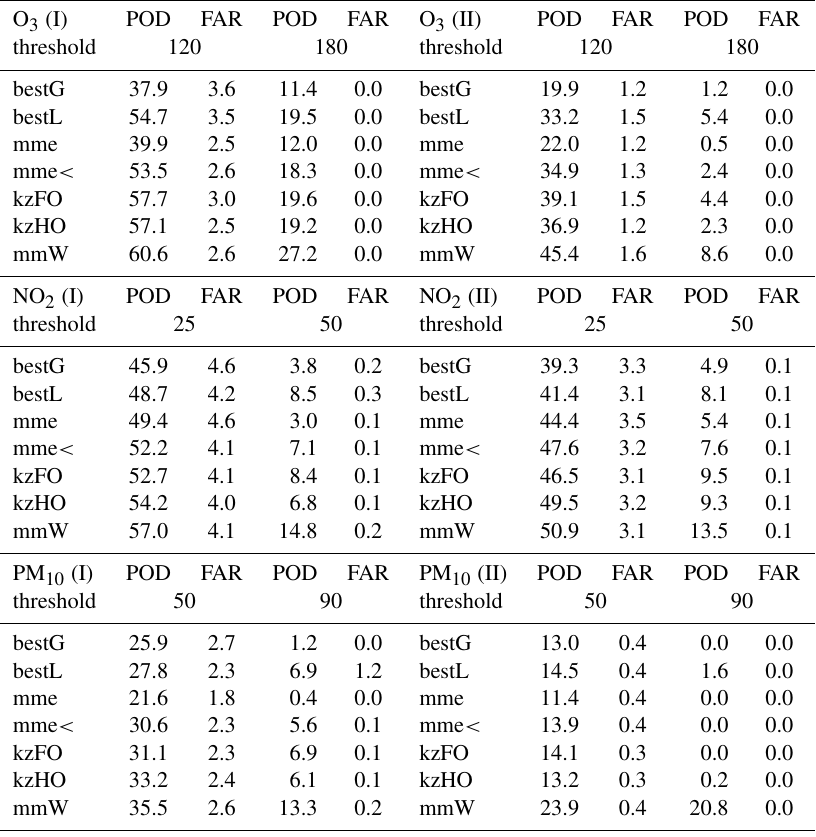
Table 4. The probability of detection (POD) and false alarm rate (FAR) from (a) the best deterministic models, globally (bestG) and lo- cally (bestL), (b) the unconditional ensemble mean (mme), and (c) the four conditional ensemble estimators (mme < , kzFO, kzHO, mmW). Two thresholds were examined for each indicator, corresponding to tail percentiles.